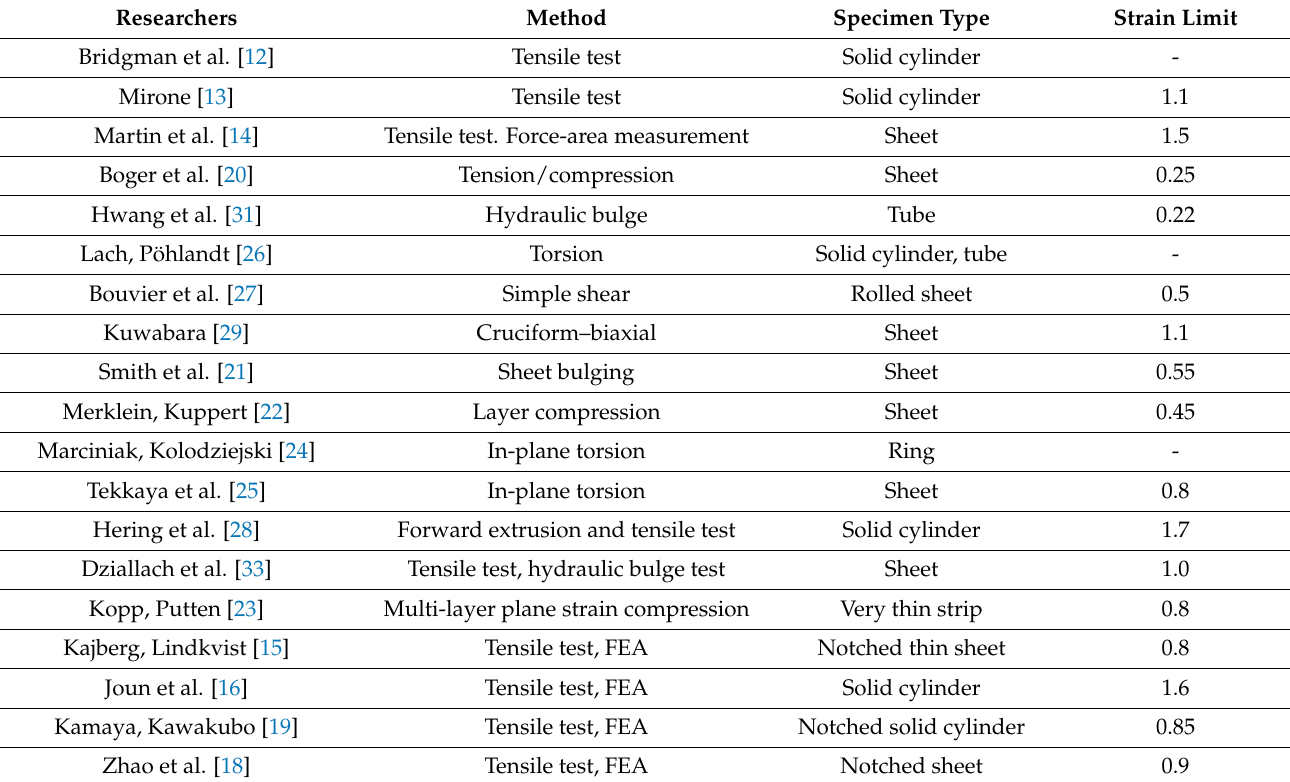
Table 1. Methods of obtaining flow behaviors at room temperature and its strain